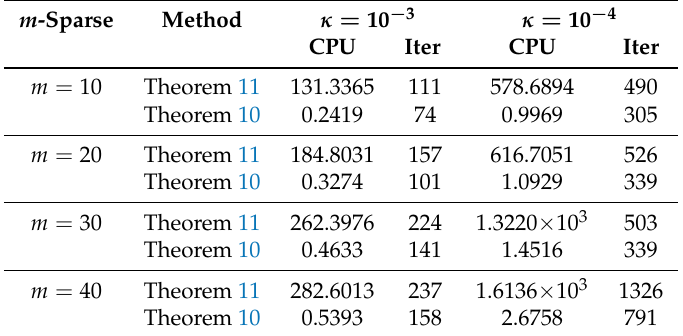
Table 6. Numerical results for the LASSO problem in case M = 2048, N = 1024.